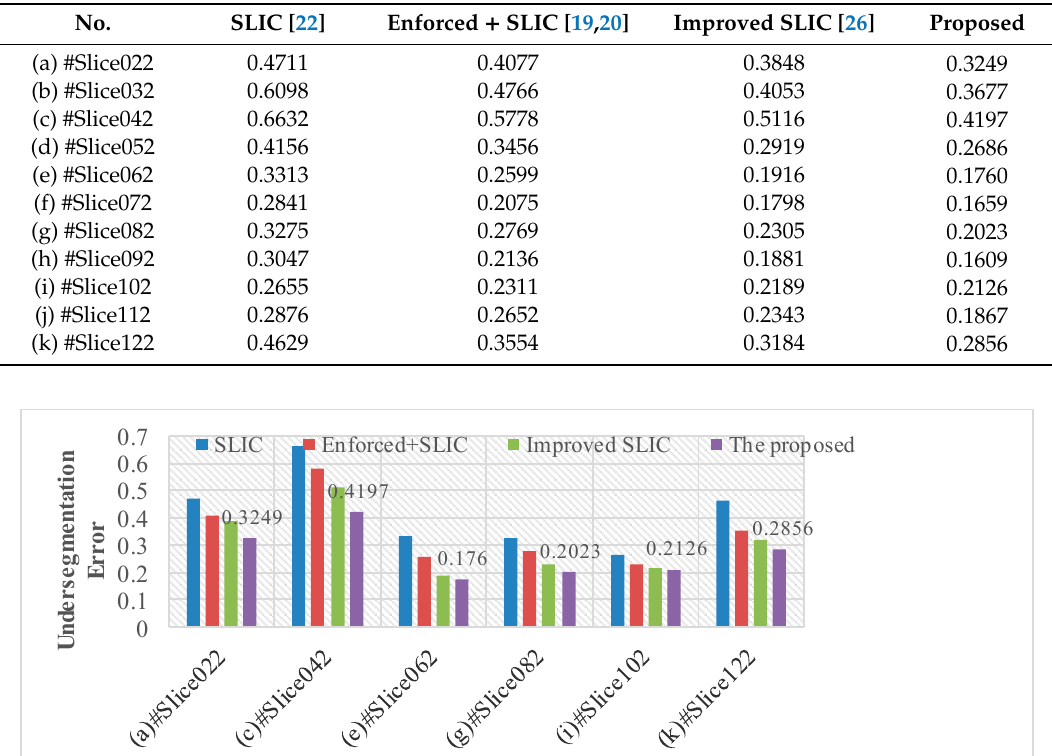
Table 1. The comparison of UE of di ff erent algorithms.